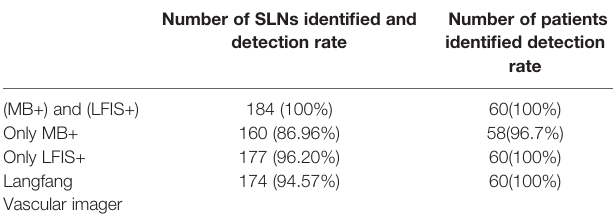
TABLE 2 | Detection rate of various methods.